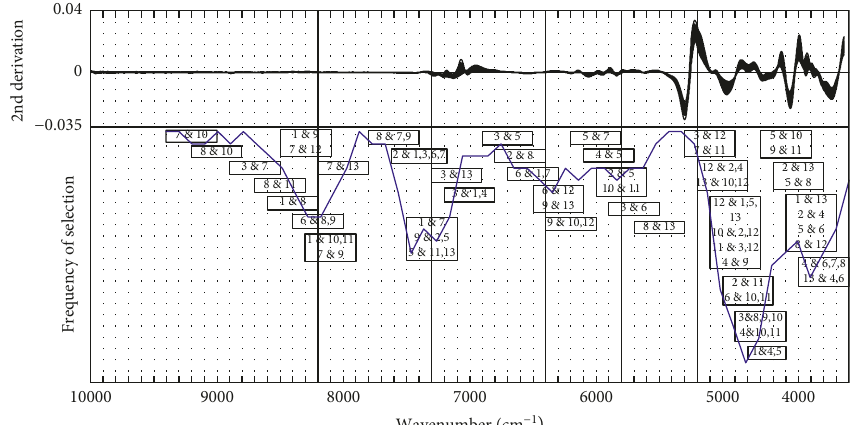
Figure 8: Location of the selected regions by L-VS based on the PLS-DA classification method. L-VS: local variable selection; PLS-DA: partial least squares discriminant analysis. Table 2: Position and assignment of the main absorption bands observed in the region between 10,000 and 4000cm − 1 . NIR band position (cm − 1 )